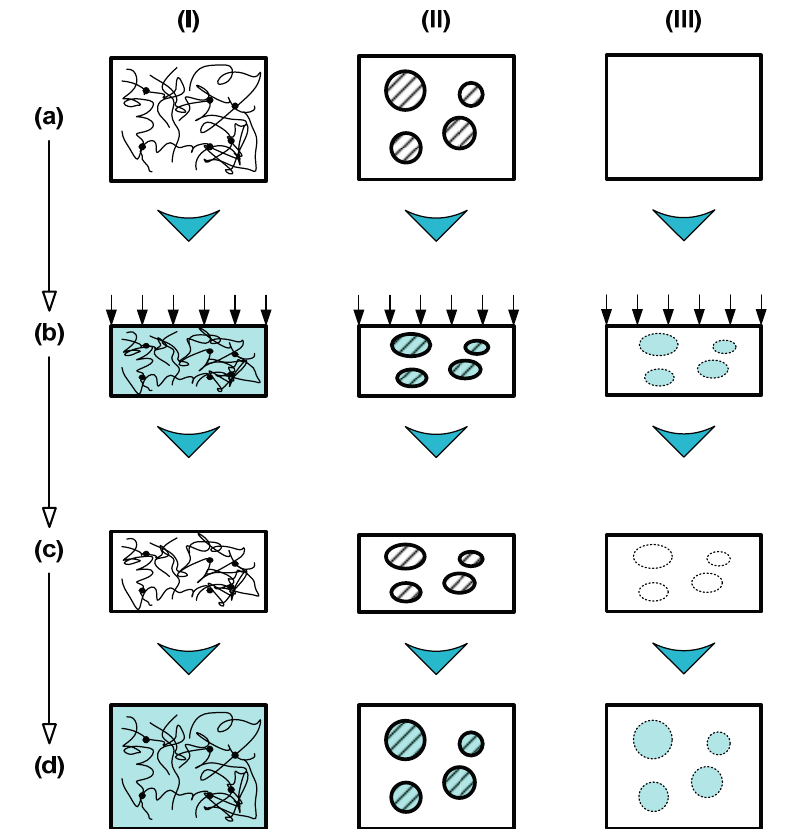
Figure 4. Basic working mechanisms of the heating-responsive SME in polymeric materials. ( I ) Dual-state mechanism (DSM); ( II ) dual-component mechanism (DCM); and ( III ) partial-transition mechanism (PTM). ( a ) Original sample at low temperatures; ( b ) upon heating and compressing; ( c ) after cooling and constraint removal; and ( d ) after heating for shape recovery